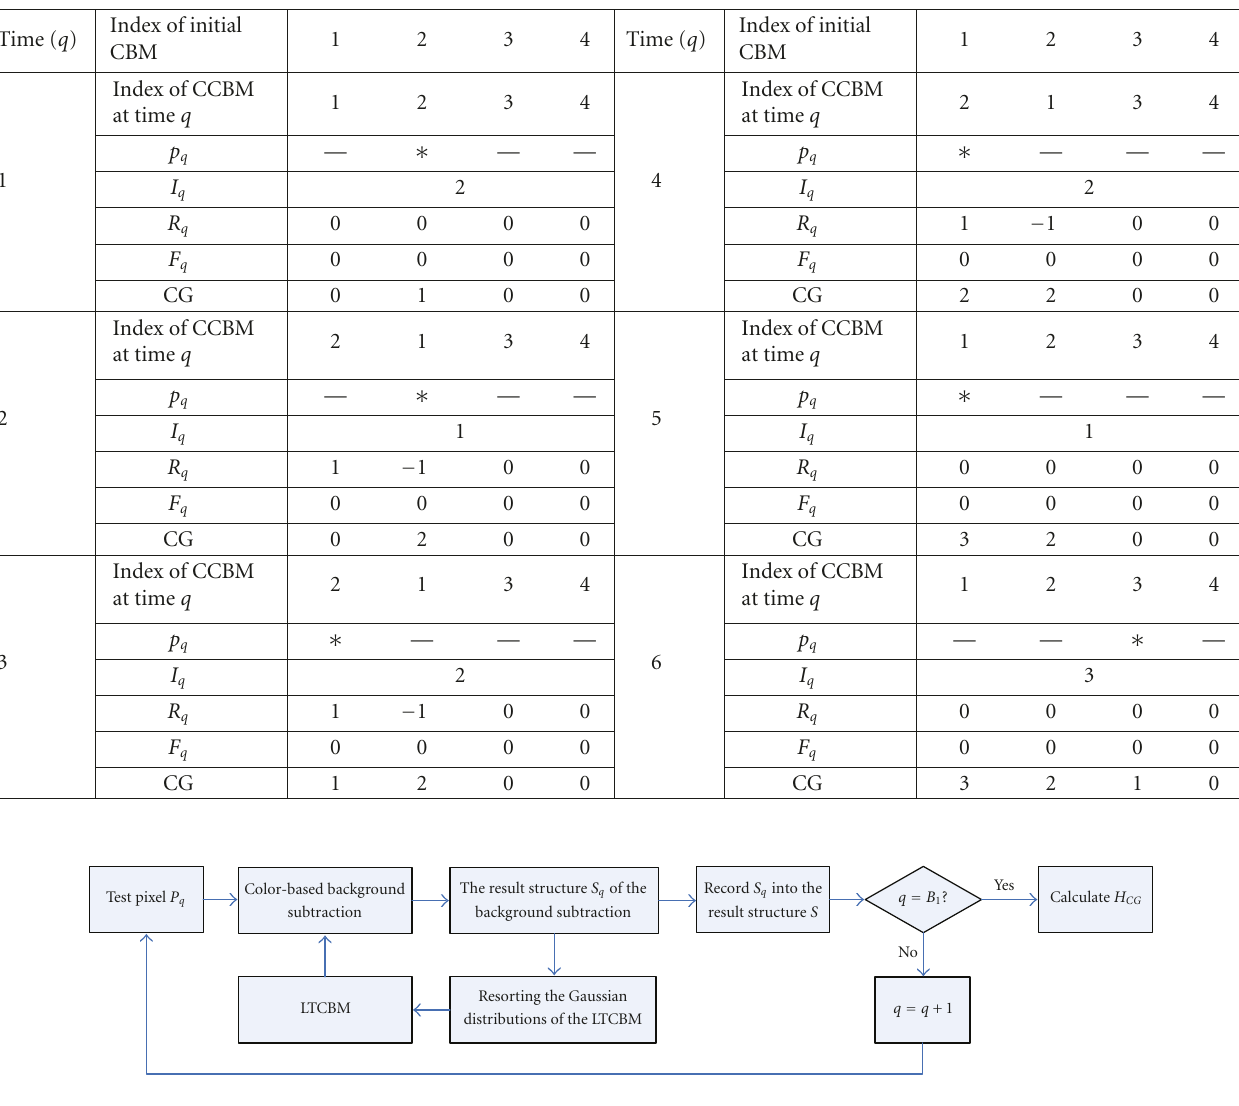
Figure 3: Block diagram showing the process to calculate H CG (the histogram of I q